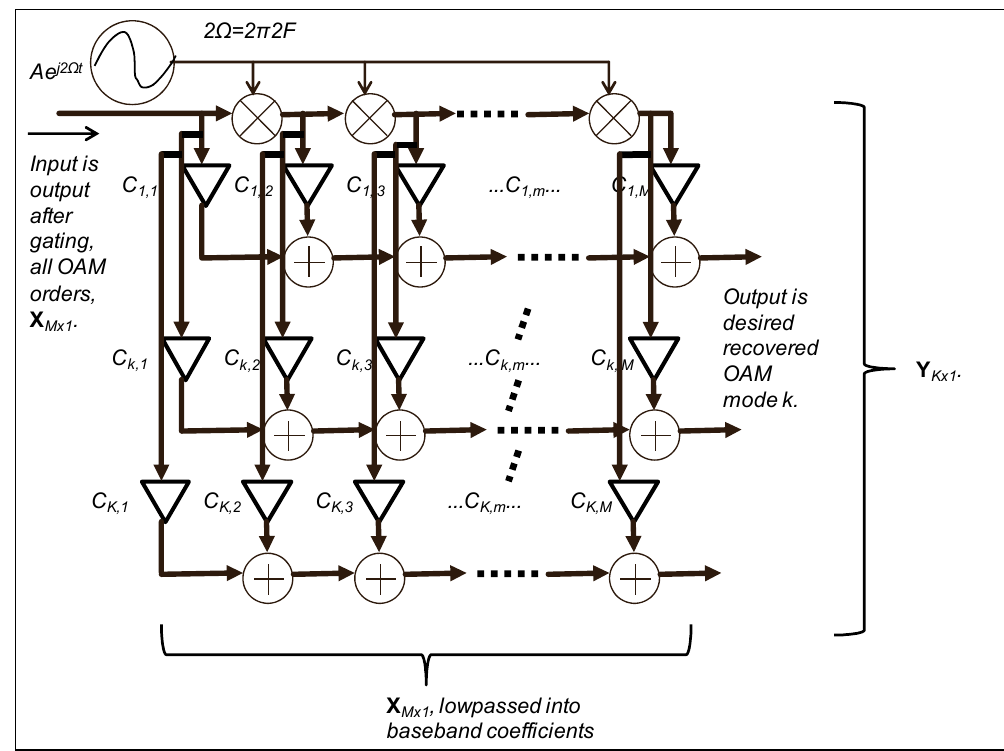
Figure 14. Functional OAM recovery algorithm from gated output of pseudo-Doppler modulation subsystem.